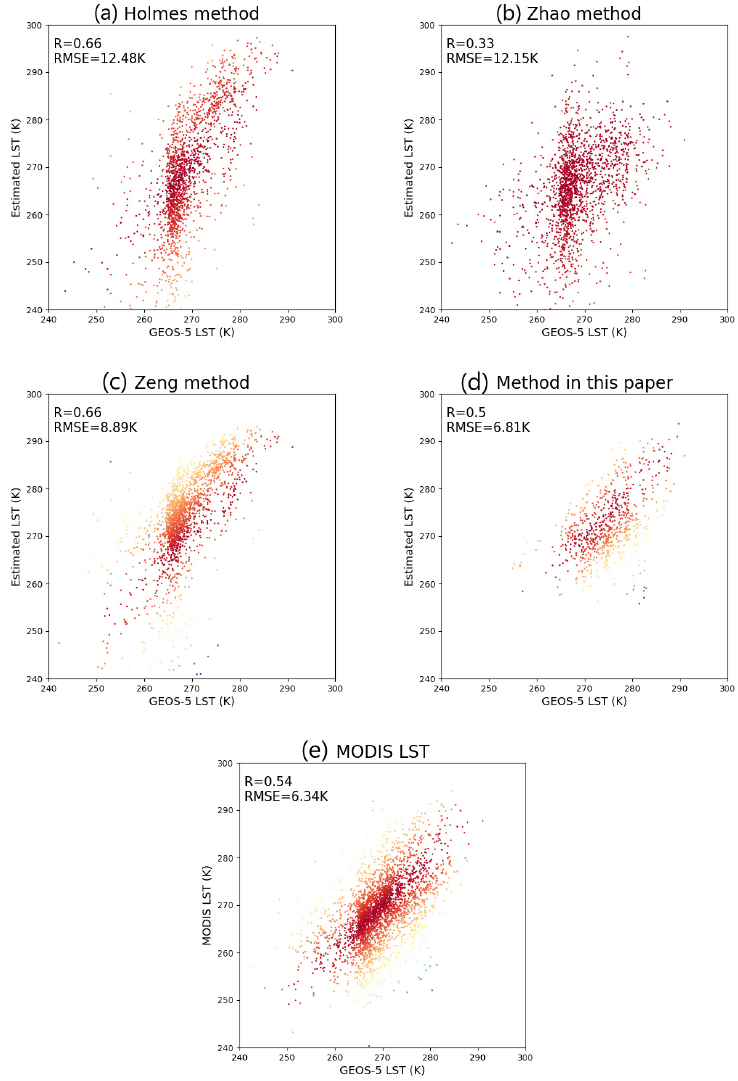
Figure 10. Coefficient of correlation (R) and root mean square error (RMSE) between the estimated LST by each method and GEOS-5 LST. ( a ) Holmes method. ( b ) Zhao method. ( c ) Zeng method. ( d ) Method in this paper. ( e ) MODIS LST. The darker color indicates a stronger correlation between two variables. Table 4. Comparison between the classic MLR-based methodology and regression techniques ima- chine learning. Table 4 is the comparison between the classic MLR-based methodology and regression techniques in machine learning. The results confirm that classic MLR is outperformed by machine learning techniques and concretely, our experiments suggest that random forest regression outperforms the rest of the techniques.